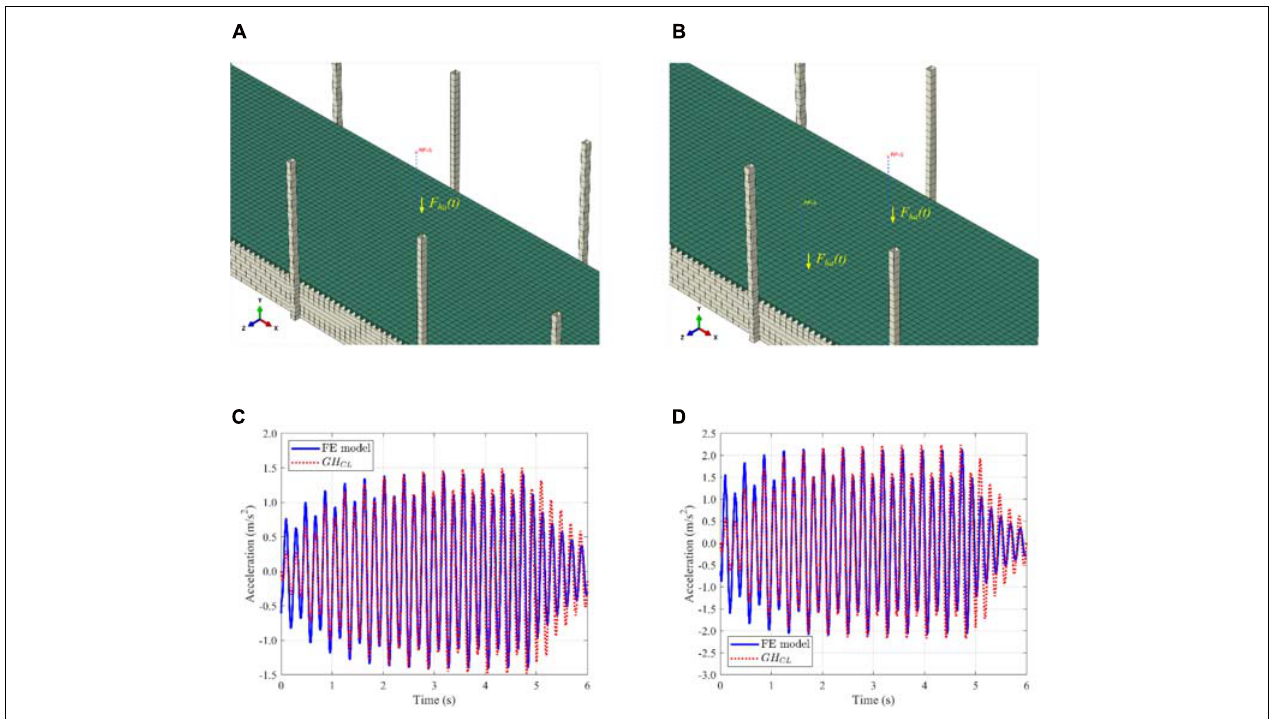
FIGURE 7 | Result comparison: (A) Mass-stiffness-damper system for 1 person, (B) Mass-stiffness-damper systems for 2 people, (C) Time history of the acceleration response for 1 person bouncing, and (D) Time history of the acceleration response for 2 people bouncing.